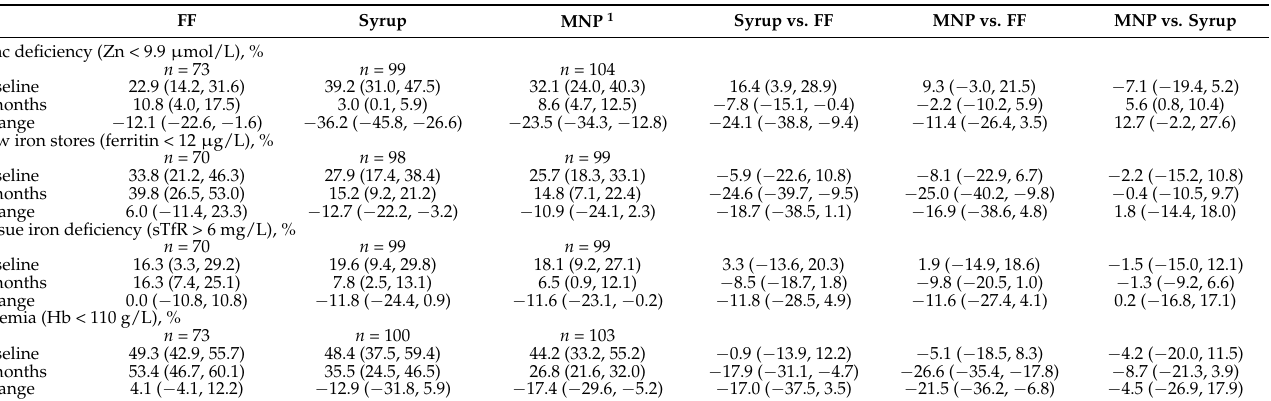
Table 4. Prevalence of zinc deficiency, low iron stores, tissue iron deficiency, and anemia, at baseline and 4 mo follow up, by study group.